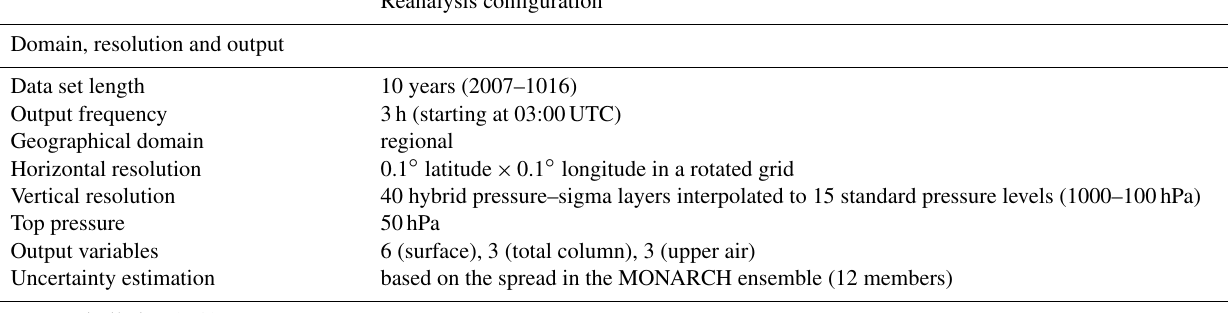
Table 1. Overview of the characteristics of the reanalysis.